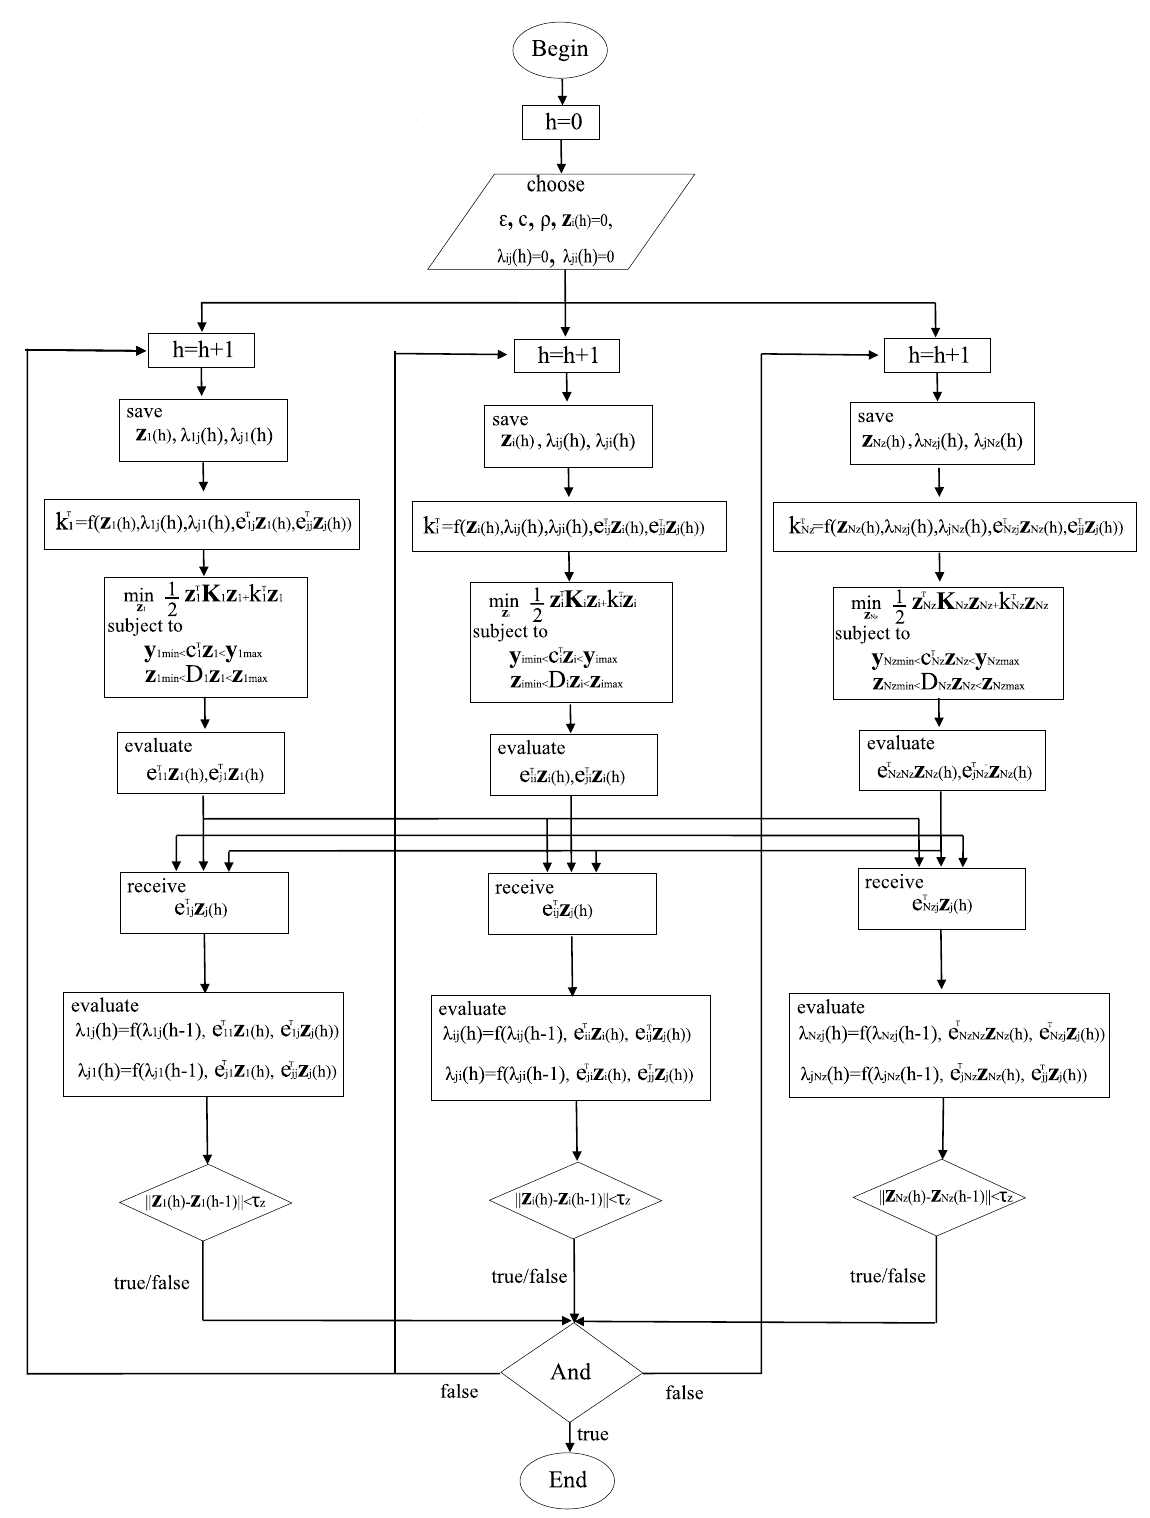
Figure 1. Distributed APP algorithm